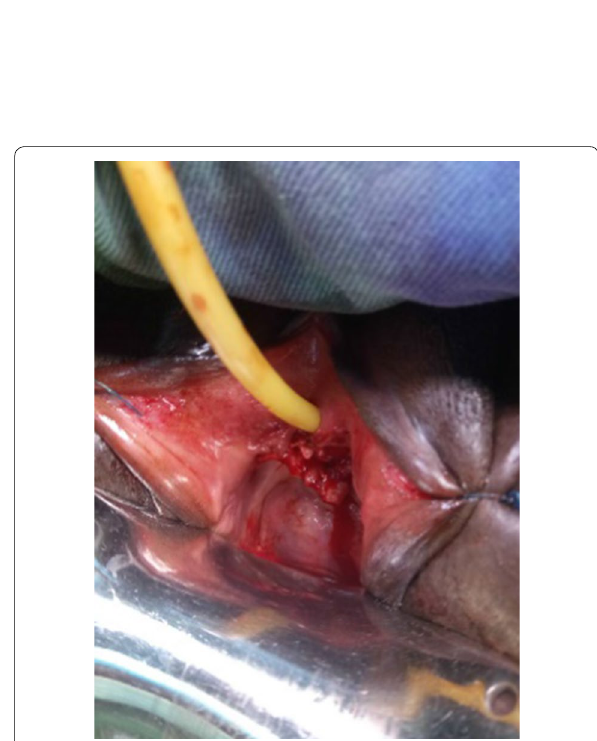
Fig. 4 Foleys urethral catheter inserted with no urine leakage after the slings were adjusted from the abdomen before the two ends were